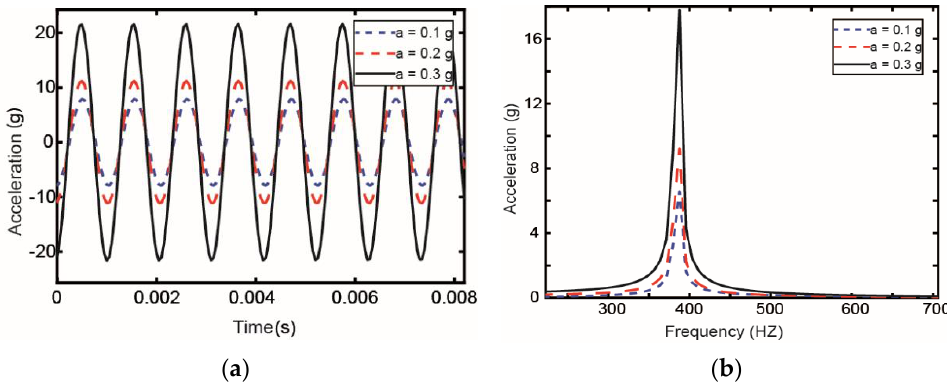
Figure 13. Vibration response in the ( a ) time domain and ( b ) frequency domain under different excitations.